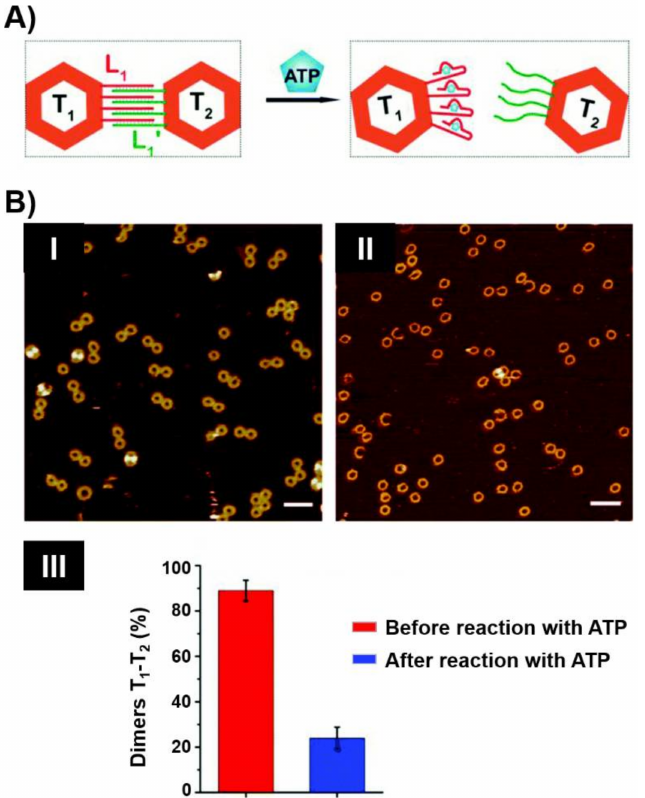
Figure 16. ( A ) ATP-triggered separation of an origami dimer by the separation of interdimer bridging units through the formation of ATP/ATP aptamer complexes. ( B ) Atomic force microscopy (AFM) images of: Panel I—the dimer origami structures; Panel II—the ATP-driven separated origami tiles: Panel III—statistical analysis of the origami tiles generated upon treatment of the origami dimers with ATP. Reproduced with permission from ref. [216]. Copyright 2017 Royal Society of